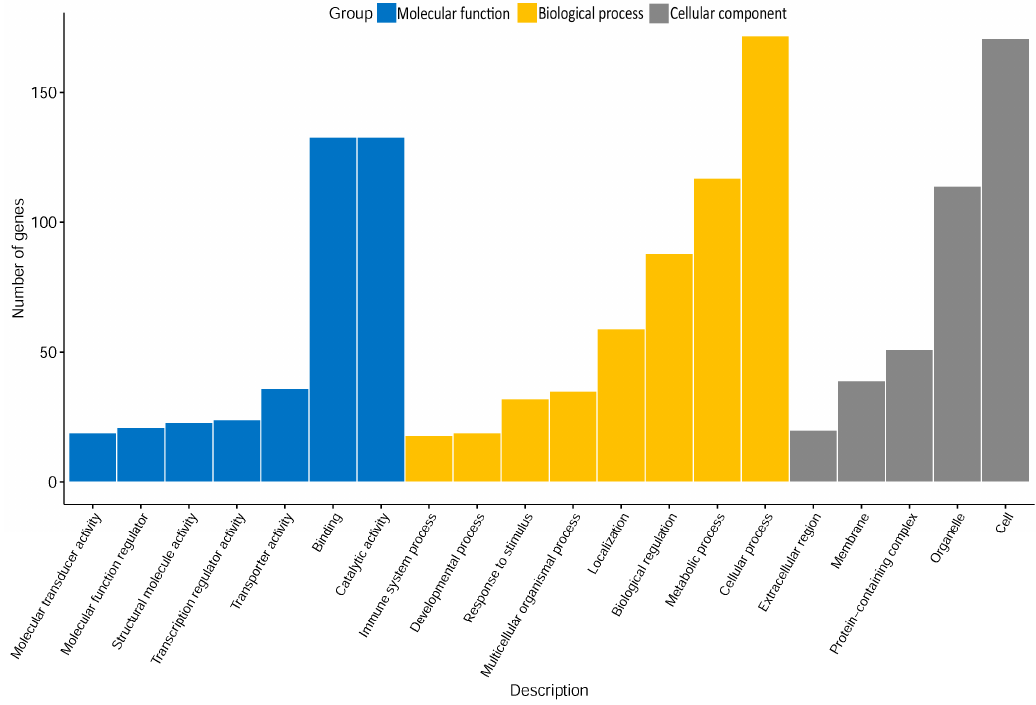
Figure 2. The Gene Ontology (GO) classification considering the 640 genes being di ff erentially expressed between quail assigned to high and low PU groups. Displayed GO terms in the categories molecular function, and biological process and cellular component include at least 10 di ff erentially expressed genes (DEGs).